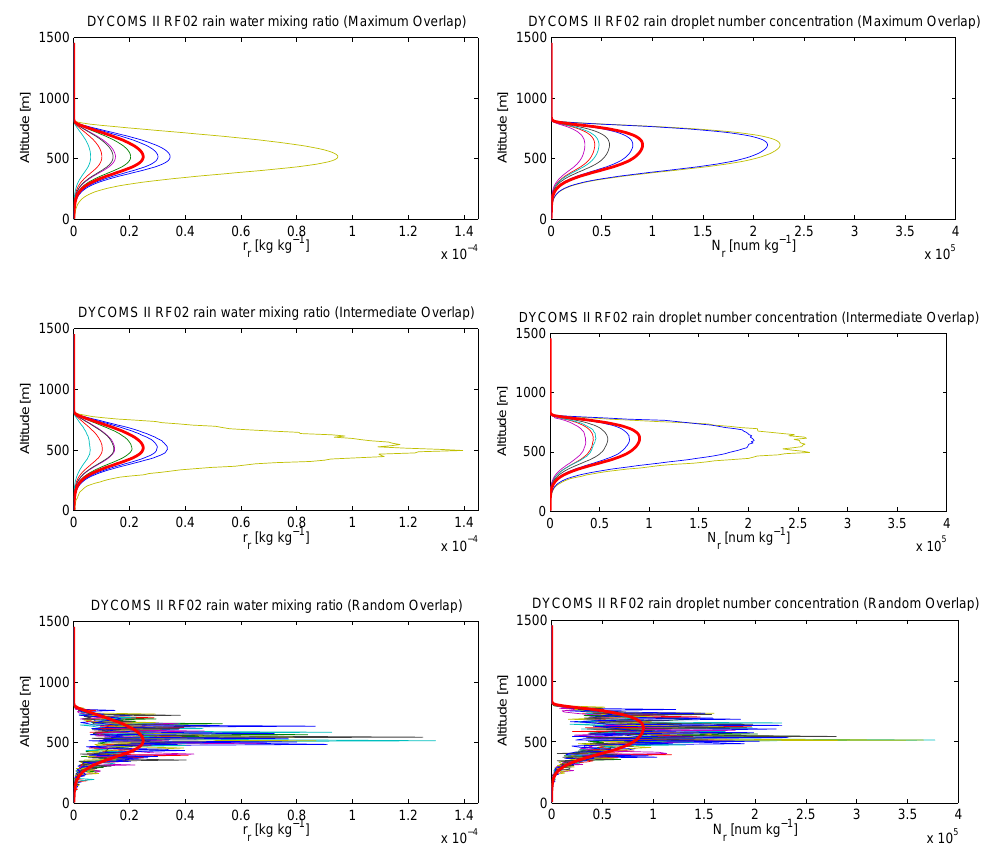
Fig. 7. As in Fig. 6, but for the DYCOMS-II RF02 marine stratocumulus simulation. The profiles of rain mixing ratio and number mixing ratio have only moderate correlation, as specified by the user.